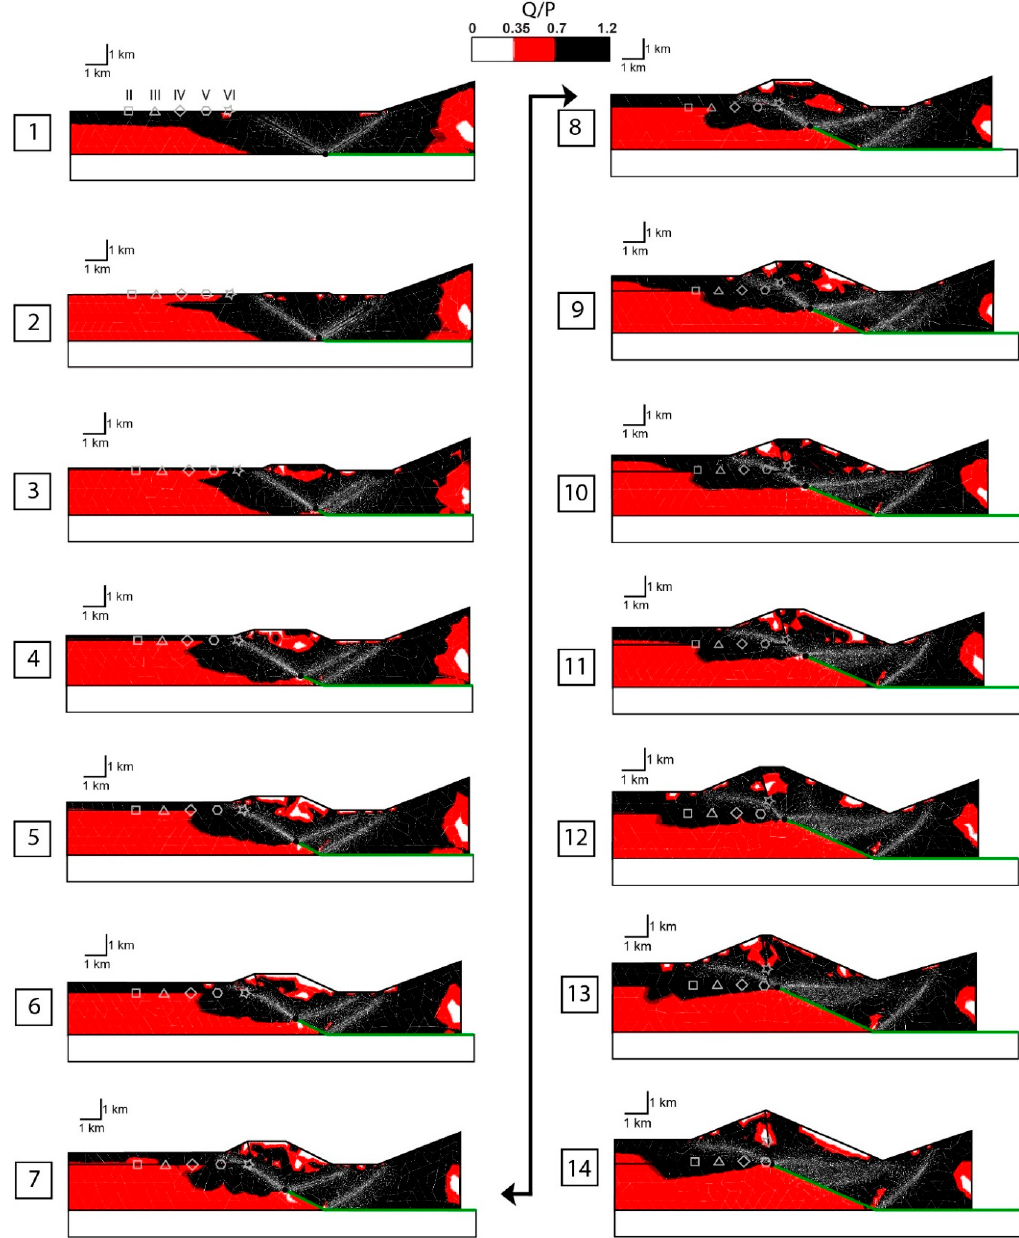
Figure 4. Q/P ratio estimated by the Limit Analysis Method (LAM) model for each step. White color is for a Q/P ratio lower than 0.35; red is for a Q/P ratio between 0.35 and 0.7; black is for ratios higher than 0.7. Shadow markers show the point measurements (Point I is not shown in this figure).